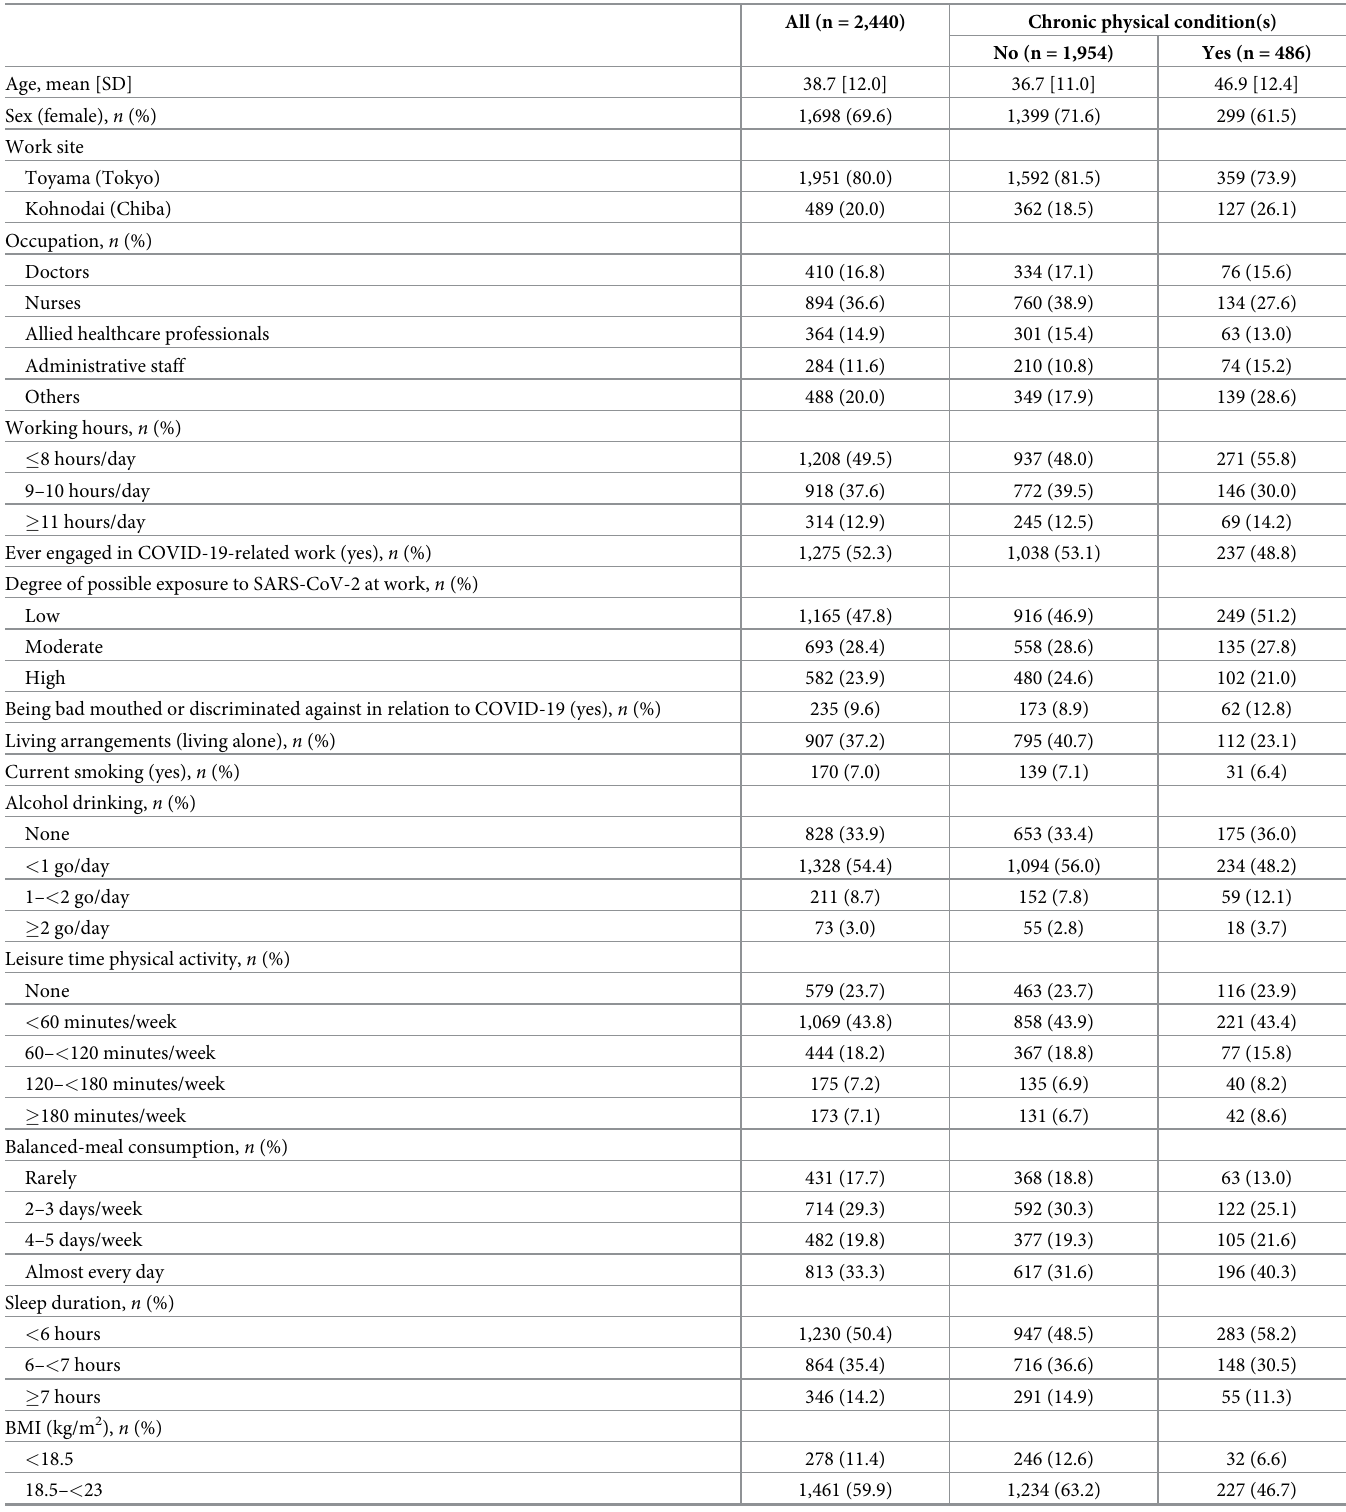
Table 1. Characteristics of study participants (n =